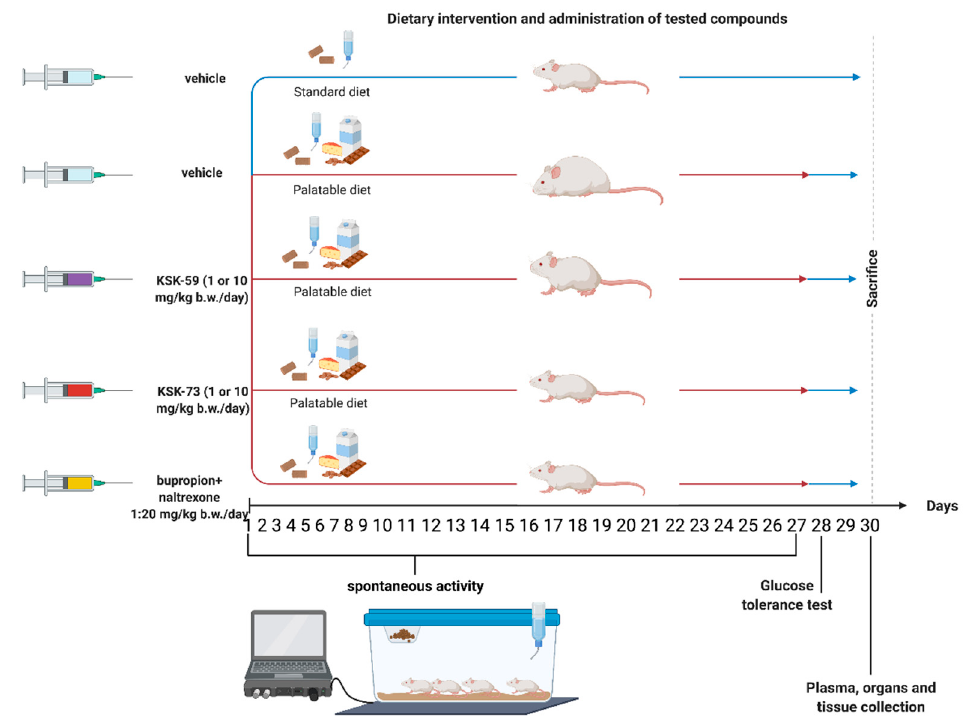
Figure 11. Scheme of the experiment.